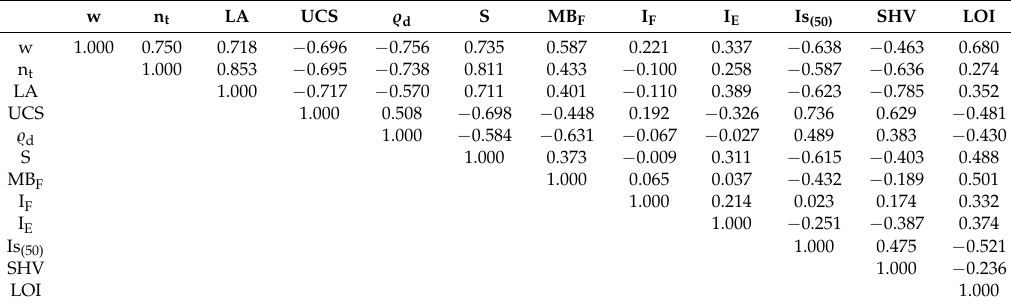
Table 5. Correlation coefficients (r) between the engineering properties.